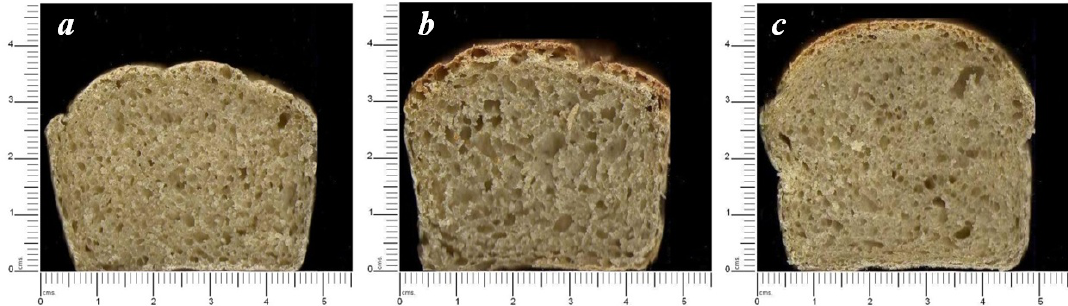
Figure 3. Cross-section of central bread slice: ( a ) control; ( b ) with commercial α-amylase; ( c ) with R. oryzae FSIS4 α-amylase.